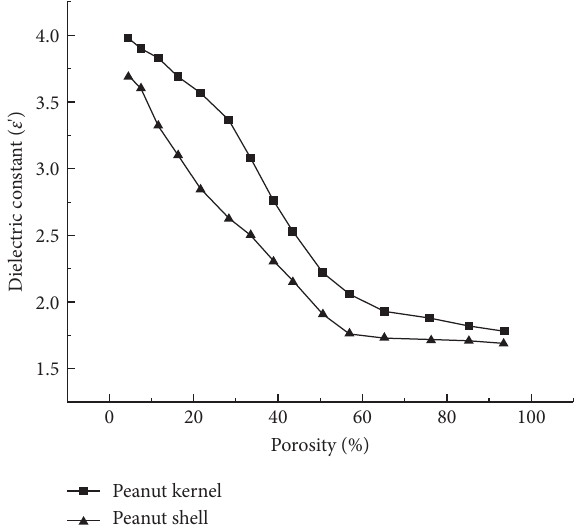
Figure 6: Efect of porosity on the dielectric properties of peanuts at diferent moisture